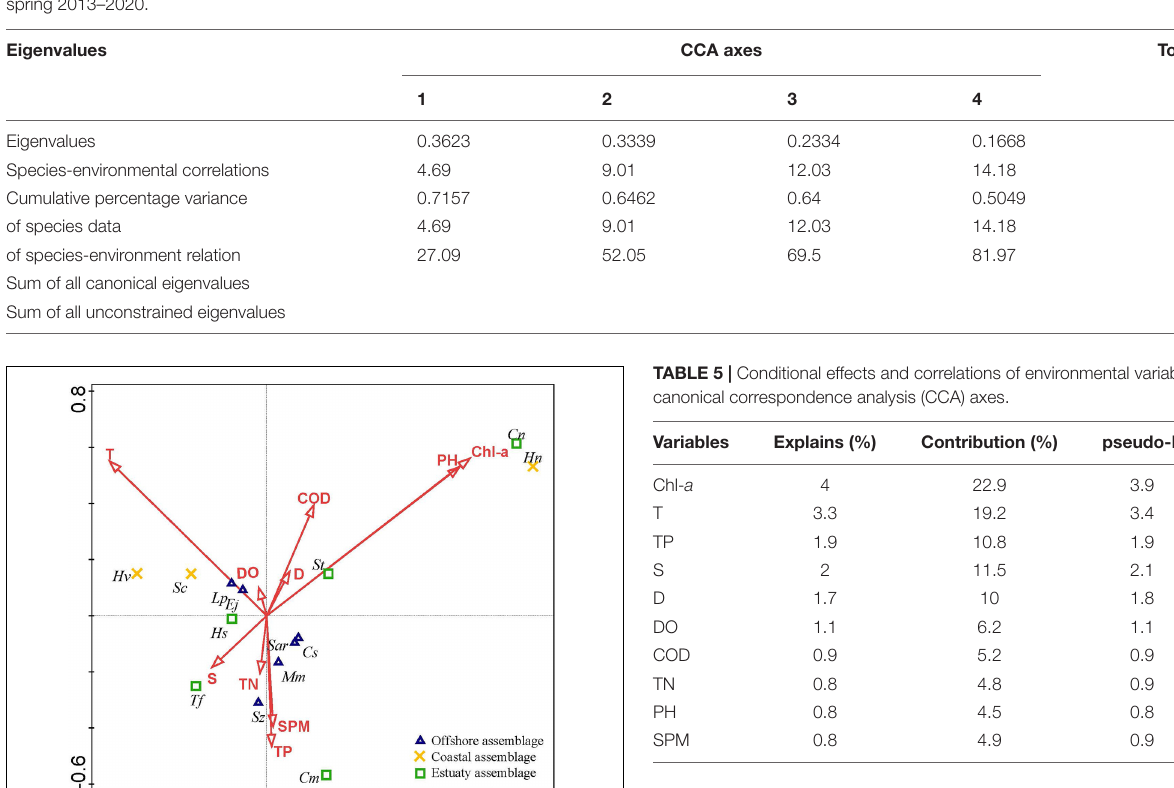
TABLE 4 | Results of canonical correspondence analysis (CCA) relating ichthyoplankton abundance data to environmental factors in the Yangtze Estuary in spring 2013–2020.